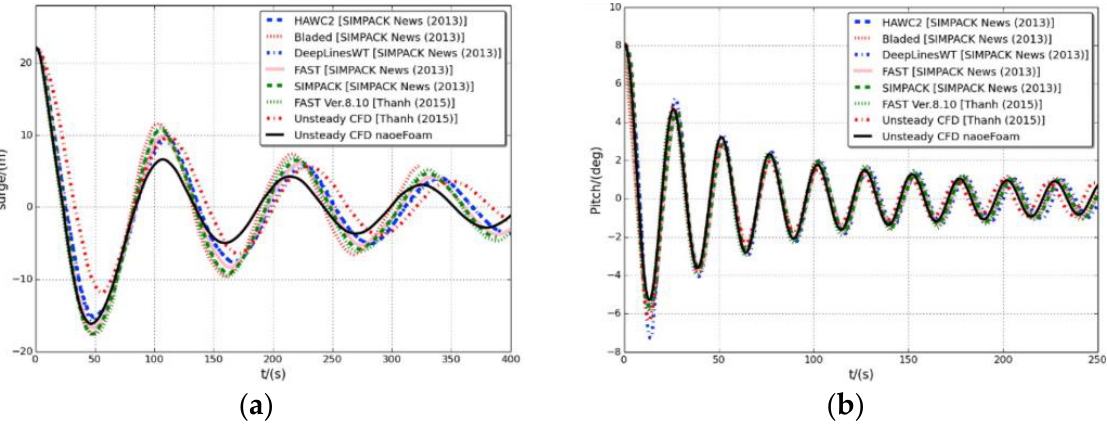
Figure 11. The free decay tests of a OC4 semi-submersible platform: ( a ) surge free decay; ( b ) pitch free decay [106]. Reproduced with permission from Cheng et al., Ocean Engineering; published by Elsevier, 2019.